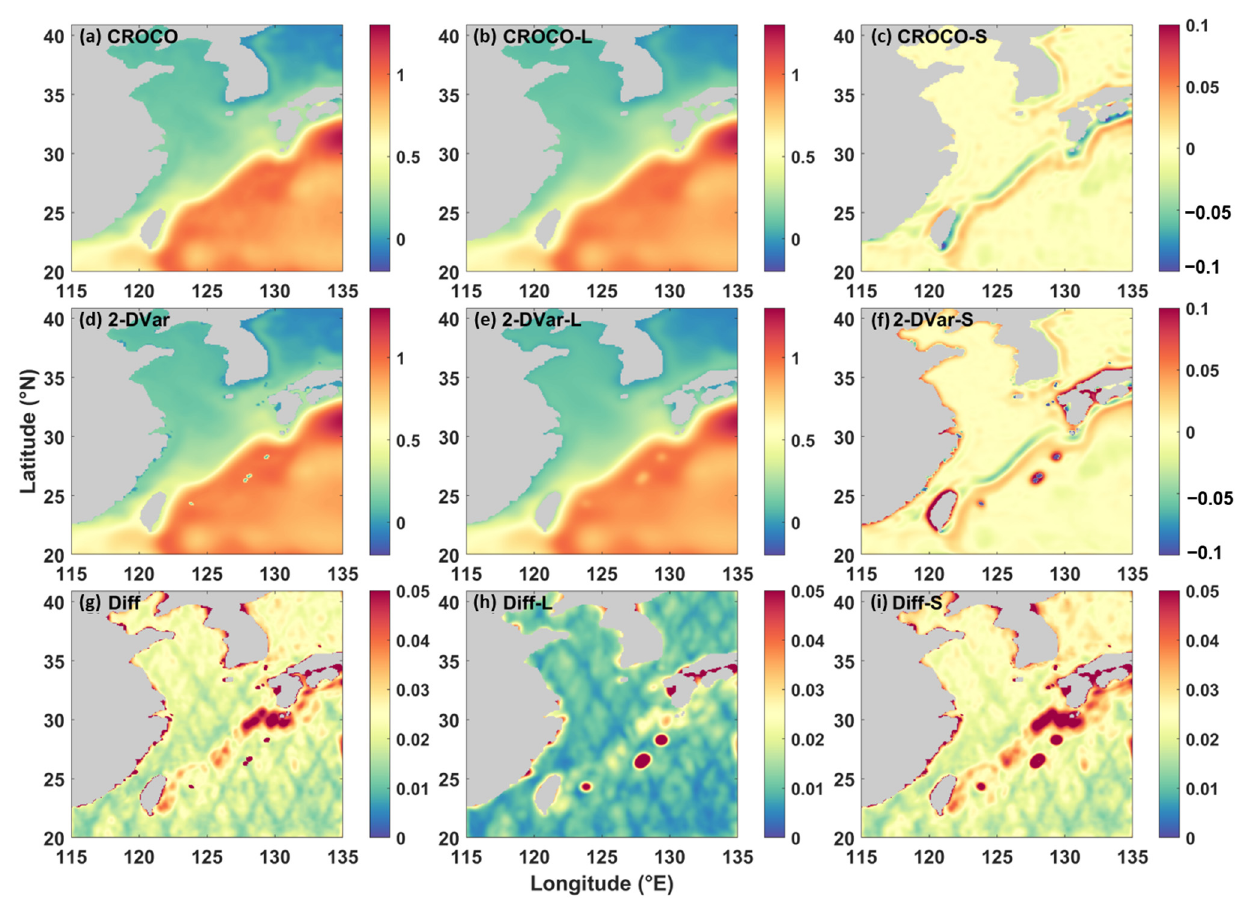
Figure 8. ( a ) Mean SSH field; ( b ) mean large-scale (reliable) SSH and ( c ) mean SSH noise from CROCO results. ( d ) Mean SSH field; ( e ) mean large-scale (reliable) SSH and ( f ) mean SSH noise from OSSE 2-DVar. ( g ) Mean absolute difference between CROCO and OSSE 2-DVar SSH fields, ( h ) low-pass-filtered mean absolute difference and ( i ) the residual component.